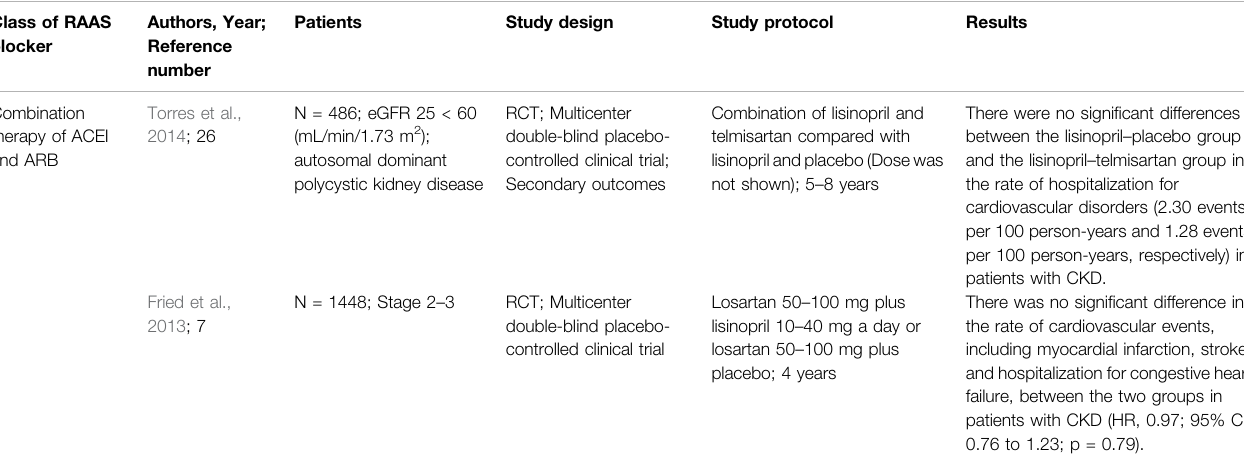
TABLE 4 | The effects of angiotensin receptor blockers and angiotensin converting enzyme inhibitor combination therapy on the development of cardiovascular disease in pre-dialysis patients with CKD. Class of RAAS